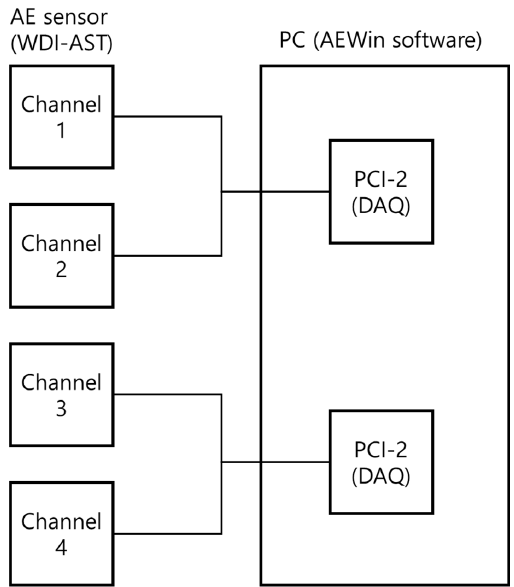
Figure 4. The channels (sensors) arrangements for the data acquisition system.